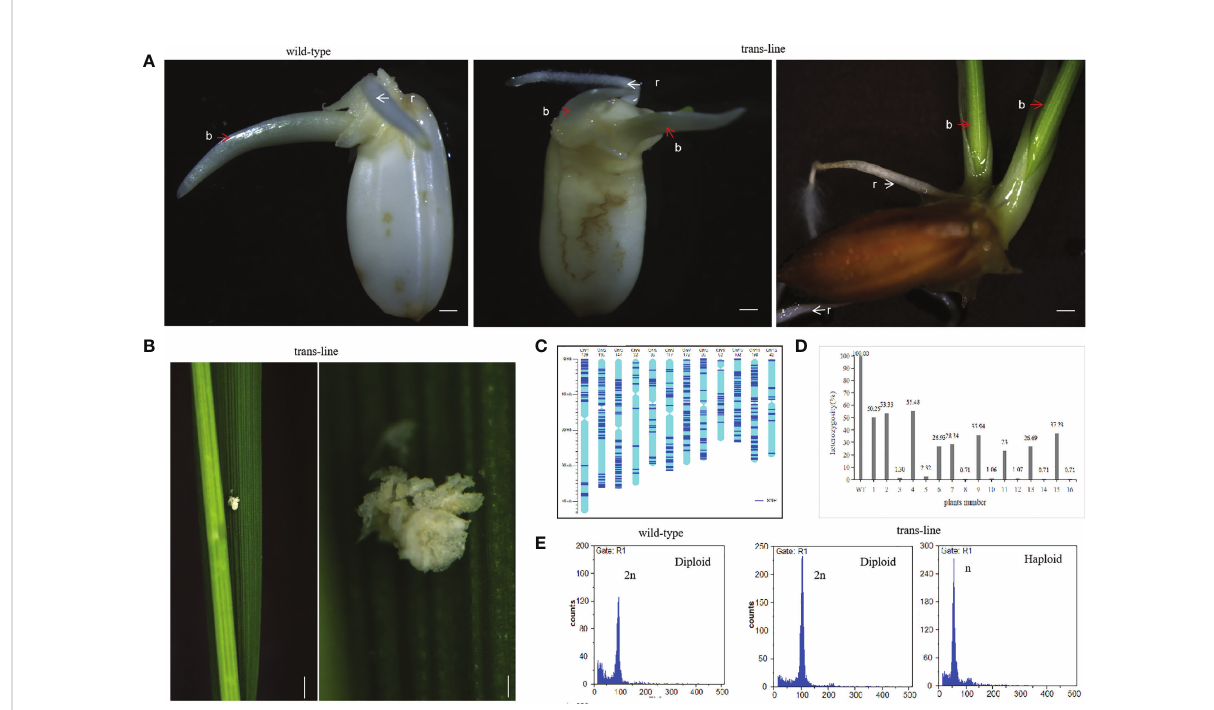
FIGURE 2 Recovery of double-seedlings in transgenic hybrid rice. (A) Seedlings in the wild-type (left; n=30) is normal with one bud (b; red arrow) and one root (r; white arrow). Double-seedlings in T 1 -generation (n=2; middle) and T 2 -generations (n=12; right) of could grown two buds(b; red arrow) and roots (r; white arrow) in trans-line. Scale bars, 1 mm. (B) Somatic embryo-like structures induced by AtWUS ectopic expression in trans-line leaves (n=20; left). Scale bars, 1 cm. The insets show magni fi ed views of the somatic embryos (right). scale bars, 0.5 mm. (C) Determination of the genotype of wild-type 9Y using whole genome sequencing. The frame of each chromosome was constructed based on the Oryza sativa ssp. japonica genome version 6.0, with the scale on the left showing the length of the chromosome (Mb) and the names of the chromosomes shown across the top of the fi gure. The heterozygous SNP sites (AB) are marked in dark blue. (D) Genotyping analysis of trans-line. The plants are shown on the x-axis and the y-axis shows the heterozygosity. Wild-type 9Y (WT), F 1 generation (1) and F 2 generation progenies of 9Y (6) as control, double-seedlings from T 1 -generation (n=2; 2-5) and T 2 -generation (n=5; 7-16) were analysed. (E) Ploidy analysis of wild-type is diploid (n=3; left), one seedling of double-seedlings in trans-line is diploid (n=5; middle) and the other is haploid (n=5; right) by fl ow cytometry. The x- axis is the measure of relative fl uorescence and the y-axis shows the number of